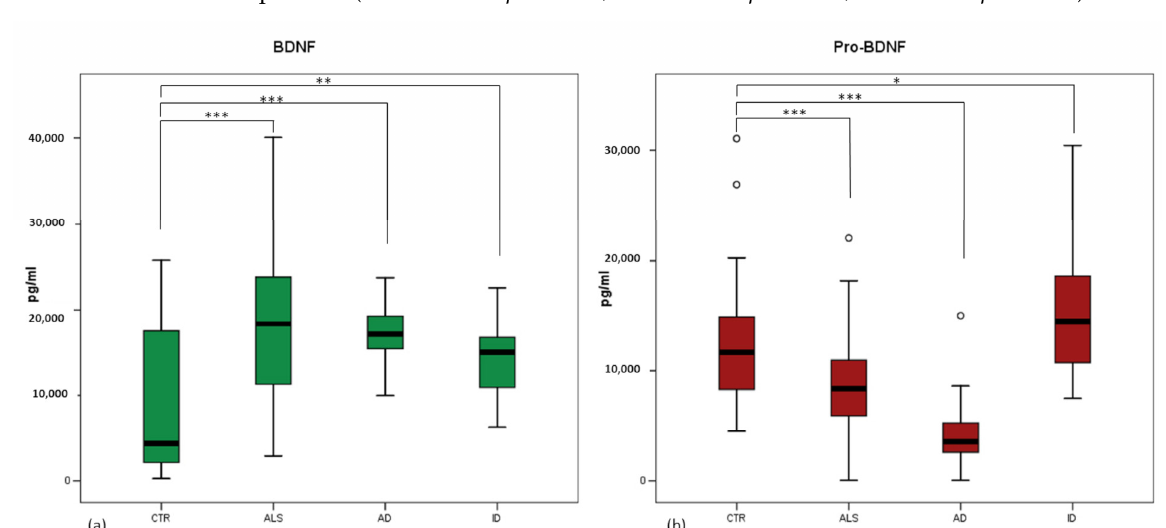
Figure 1. Boxplots showing BDNF ( a ) and Pro-BDNF ( b ) amounts in serum of the three groups of patients (Amyotrophic Lateral Sclerosis, ALS; Alzheimer Disease, AD; Inflammatory Diseases, ID) and healthy controls (CTR). ( a ) BDNF levels are strongly significantly increased in ALS and AD patients and less significantly increased in ID patients, compared to control group. ( b ) Compared to controls, Pro-BDNF is decreased in a significant manner in ALS group and even more in AD group, while Pro-BDNF is increased in ID patients. Black horizontal line: median; o : outliers. *: p < 0.05; **: p < 0.001; ***: p < 0.0001.